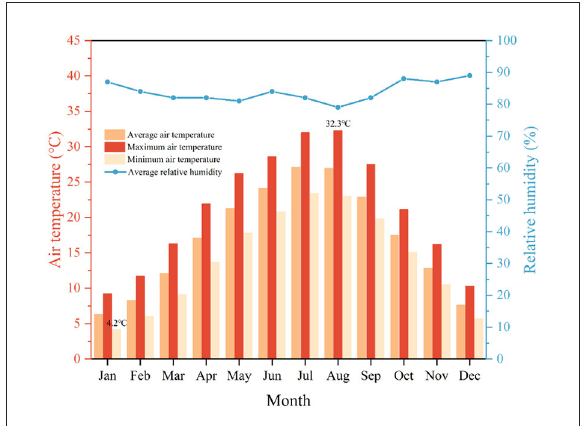
FIGURE3 Monthly average, maximum, and minimum T a and RH in Linshui from 1981 to 2010. Elaborated by the authors using the data from the National Meteorological Science Data Center, website: http://data.cma.cn/.